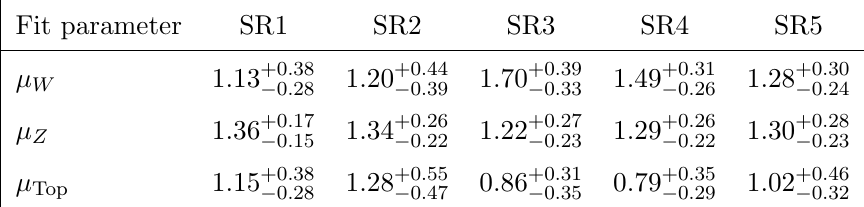
Table 4 . Normalisation factors after the background-only (cid:12)t. The central values with the detector- related systematic uncertainties, corresponding to one standard deviation, are